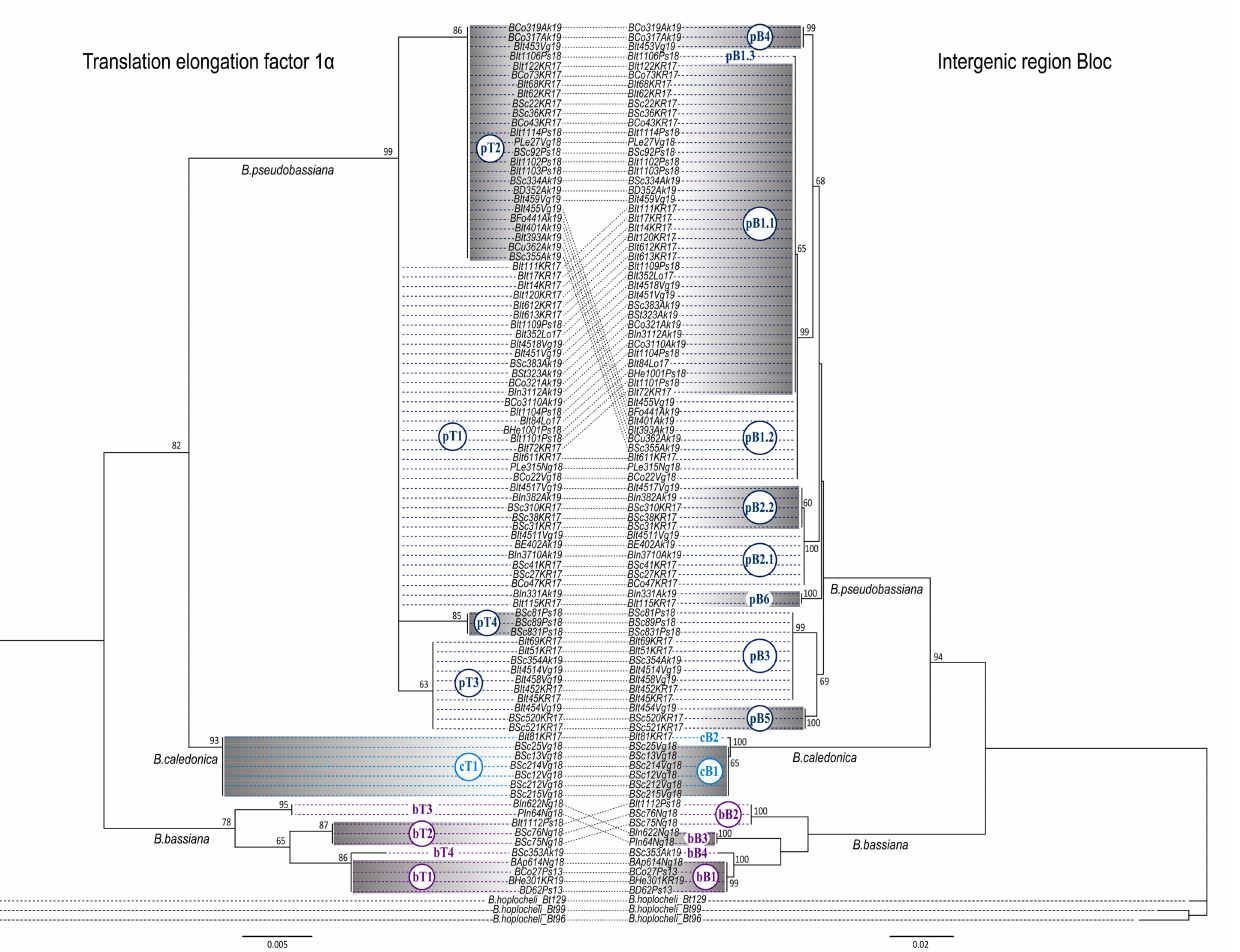
Figure 1. Phylogenetic trees of Beauveria spp. based on the maximum likelihood (ML) analyses of two locus (TEF gene and nuclear intergenic locus Bloc). ML bootstrap values (>50%) are shown at the nodes. Gray and white areas separate alternating alleles. Alleles of each locus are designated with individual index numbers. Beauveria species epithets pseudobassiana , bassiana , and caledonica are indicated with lowercase letters (p, b, and c), TEF and Bloc alleles with capital letters (T and B), and then numbers in order of abundance. Beauveria pseudobassiana was divided into six clades by Bloc, with the subsequent hierarchical allelic